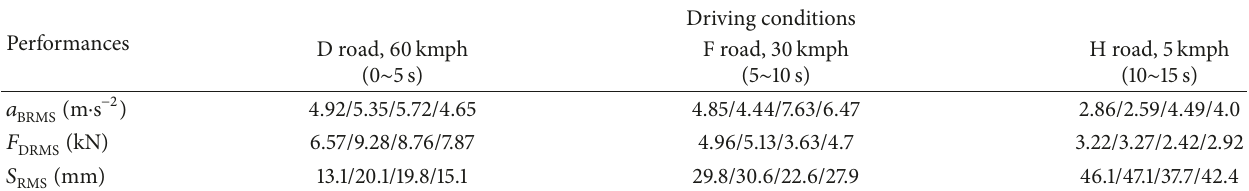
Table 6: Comparison of suspension performances of different control strategies (hybrid/skyhook/ground hook/passive). Performances